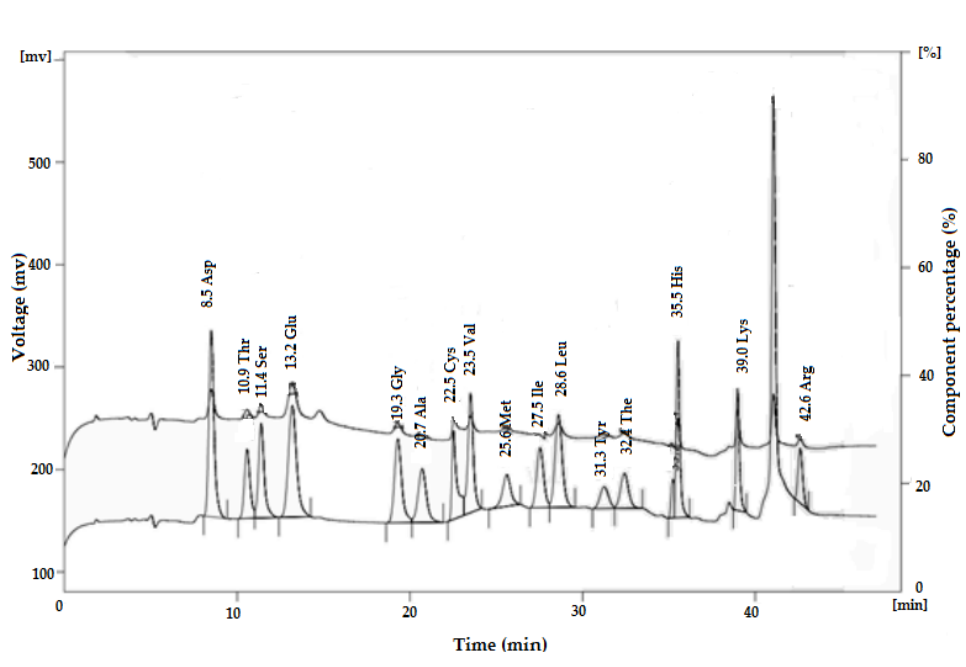
Figure 1. Composition of amino acids of PPPT.